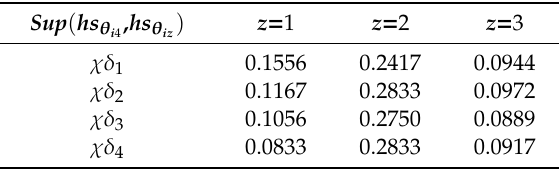
form hs θ iz i 4